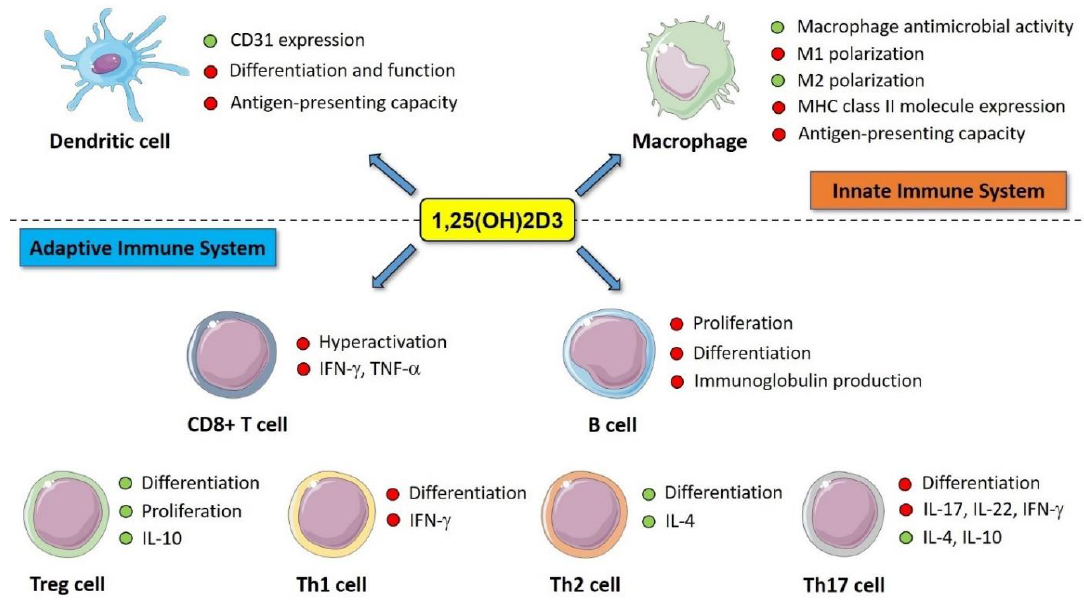
Figure 2. An overview of the anti-inflammatory and immunomodulatory effects exerted by the active metabolite of vitamin D 1,25(OH)2D3 (referred to as calcitriol) on innate and adaptive immune system. Red dots represent downregulation, whereas green dots represent upregulation. Abbreviations: IFN- γ , interferon gamma; IL-4, interleukin 4; IL-10, interleukin 10; IL-17, interleukin 17; IL-22, interleukin histocompatibility complex; TNF- α , tumor necrosis